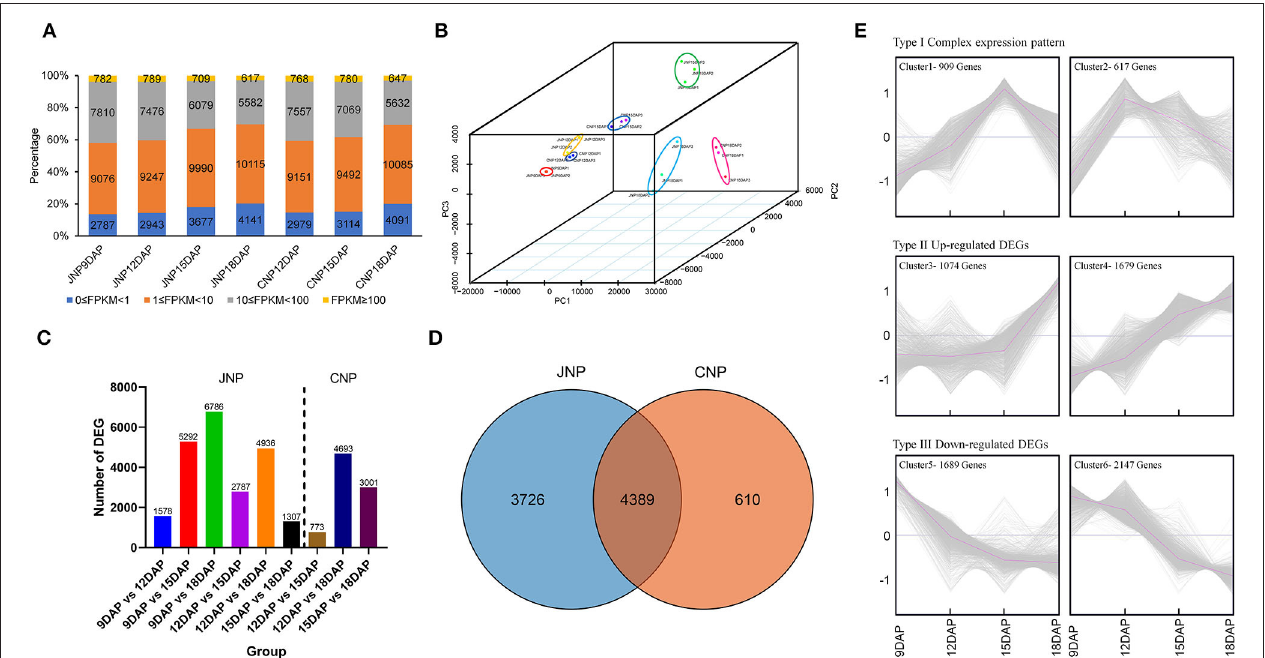
FIGURE 2 | Transcriptome profiling and identification of differentially expressed genes (DEGs) in lotus plumule. (A) The gene FPKM expression levels of each sample. (B) 3D-PCA plot showing sample clusters based on gene expression levels. (C) Number of DEGs between different comparison groups. JNP and CNP represent lotus plumule of cv. “Jianxuan 17” and cv. “China Antique,” respectively. (D) Venn diagram showing the number of overlapping DEGs between JNP and CNP. (E) Cluster analysis of 8,115 DEGs identified in JPN based on the K-means method. The gray and purple lines in the panels indicate the expression levels of individual genes and the consensus of all genes in a specific